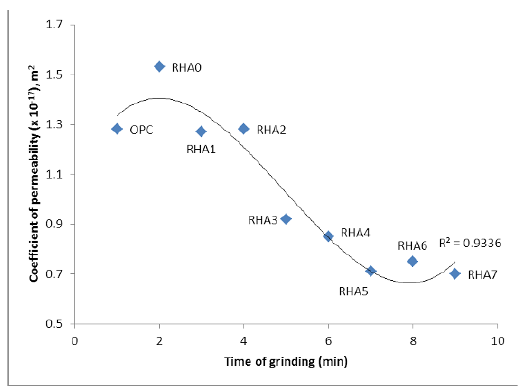
Figure 8. Permeability of OPC and RHA at varying grinding time at 28 days.